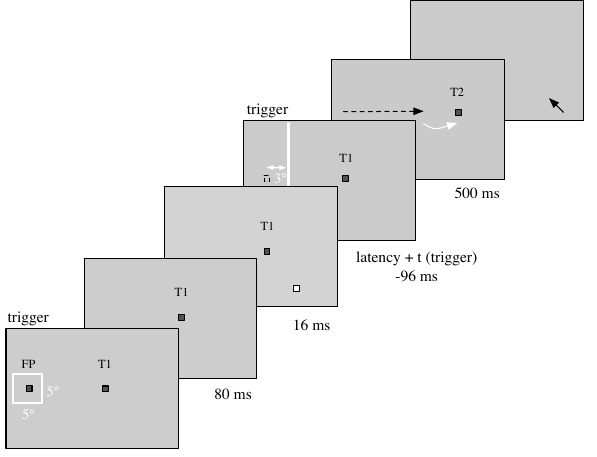
Figure 4 . Target on/Target off localization judgements. The subject initially fixated FP, which was visible for a variable time between 500 and 1300 ms. Gaze was triggered to a 5 x 5 deg window centered around FP. As soon as FP was extin- guished the subjects had to perform a saccade to T1. Eighty ms after this go-signal a 16 ms flash appeared at one of the testing positions. When gaze crossed the threshold 3 deg rightwards to FP T1 jumped to T2 (target on condition) or was extinguished (target off condition, not shown). 500 ms later a mouse pointer appeared and the subject had to indicate the perceived flash position.